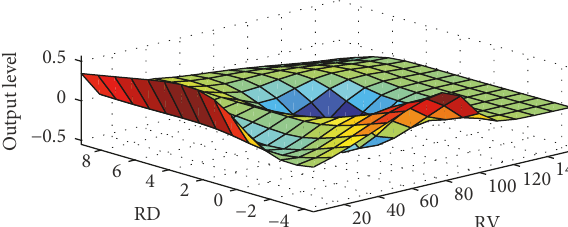
Figure 6: Surface view of the trained rules for RV and RD and the corresponding output